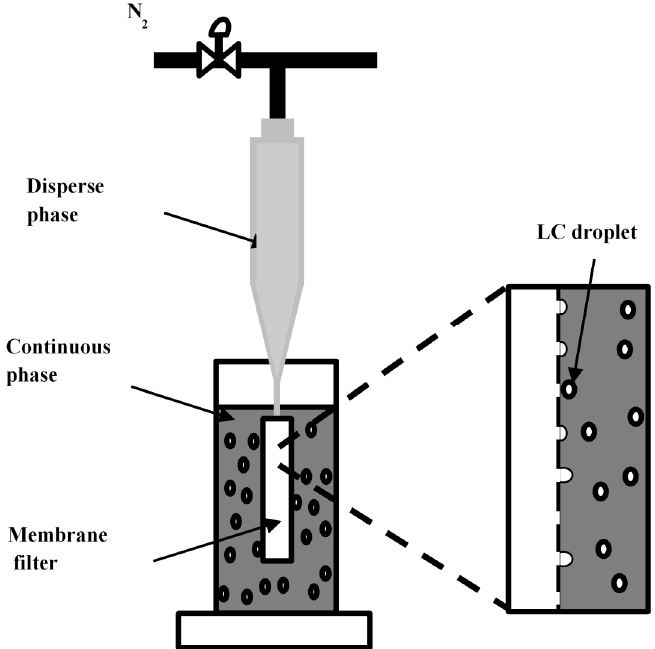
Figure 1. Schematic diagram of membrane emulsification. The dispersed phase escapes through the porous membrane filter into the moving continuous phase. At the surface of the membrane filter, the dispersed droplets, which pass though the pore of the filter, will be detached by the shear stress in the continuous phase. In this way, droplet size can be effectively controlled by the shear stress.